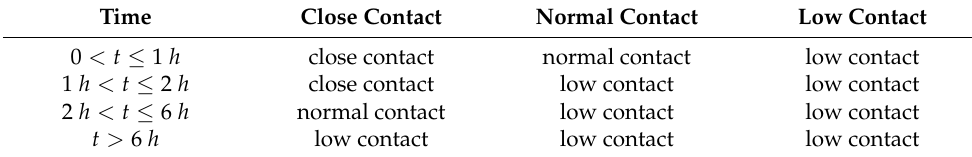
Figure 6. A’s close contact individuals are B, D, and E. In general, because of the limitation of resources, we should first allocate resources to people who have a higher probability of infection. This is much better than allocating resources aimlessly and randomly. The tracing data then play an important role. 4. Results and Discussion The model is for COVID-19 control in school. Hence, effectiveness relies on the COVID-19 control effect and its cost. Schools using this model are expected to have lower infection risk, and lower costs, compared to harsh and one-size-fits-all solutions. The real- world infection risk test is not applicable at the present time. Since the principles to design the model are pandemic control rules which are demonstrated as valid by many scholars, we can test the effectiveness of components of the model instead. 4.1. Current Efforts for COVID-19 Control in School Since the first COVID-19 case was confirmed (circa 2019), we have suffered great losses. Many people have known that SARS-CoV-2 is not a simple virus [61], although some infected people have mild symptoms, similar to influenza. The complexity and vol- atility of the COVID-19 pandemic challenge human beings: it is hard to predict the emer- gence of variants, some people who are vaccinated still become infected [62], asympto- matic infections are difficult to detect in time, etc. Due to the difficulties of tackling the pandemic, straightforward one-size-fits-all strategies are often conducted. One-size-fits-all has two meanings. Both being blind to the pandemic and taking in- flexible measures are seen as one-size-fits-all solutions. Although some people claim that COVID-19 is just a flu, which deserves no special attention, people are still making efforts